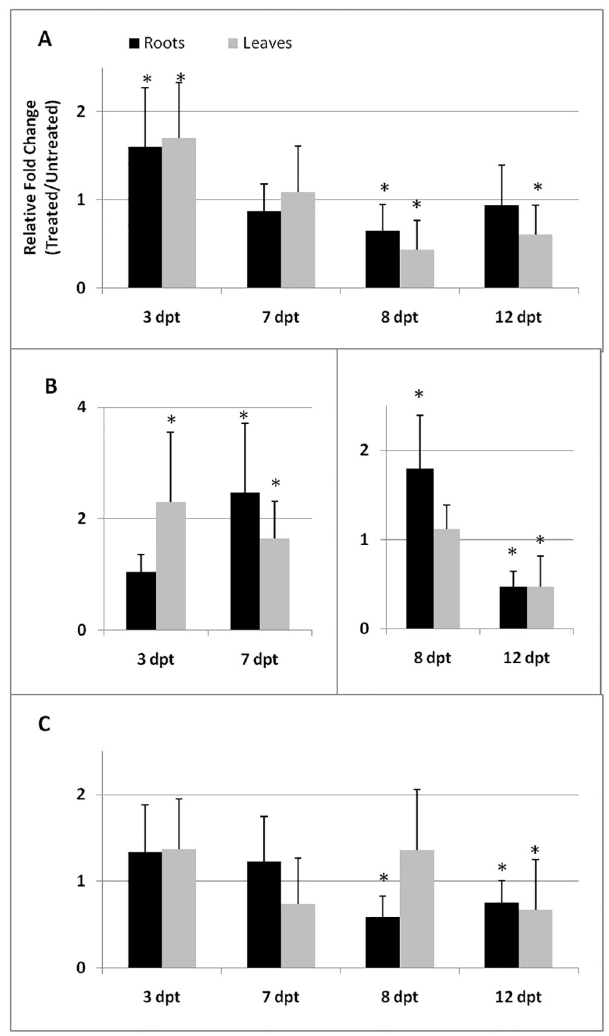
Fig 2. Expression of JERF3 , CAT , and ACO genes in tomato tissues after treatment with BCAs. Expression of JERF3 (A), CAT (B) and ACO (C) genes was detected by quantitative real-time reverse-transcription polymerase chain reaction (qRT-PCR) in roots and leaves of susceptible tomato plants at 3, 7, 8, and 12 days post treatment (dpt) with BCAs. Data are the mean fold changes ( n = 6) ± SD in gene transcript levels of tissues from BCA-treated plants relative to those from untreated control plants (the value 1 indicates no change). An asterisk ( � ) indicates that the mean fold change is significantly different from 1 as determined by the non-parametric Kolmogorov-Smirnov test ( P < 0.05).